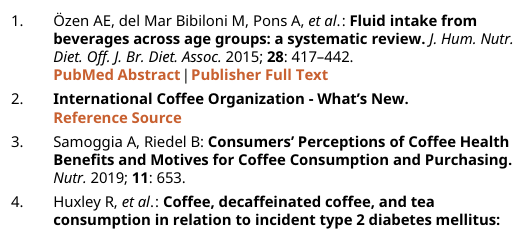
Figshare: PRISMA_2020_checklist. The contradictory effects of coffee intake on periodontal health- a systematic review. DOI: https://doi.org/10.6084/m9.figshare.20412261.v1. 25 Figshare: PRISMA Flowchart. DOI: https://doi.org/10.6084/m9.figshare.20412252. 26 Figshare: Table - The contradictory effects of coffee intake on periodontal health- a systematic review. DOI: https://doi. org/10.6084/m9.figshare.20412270.v1.